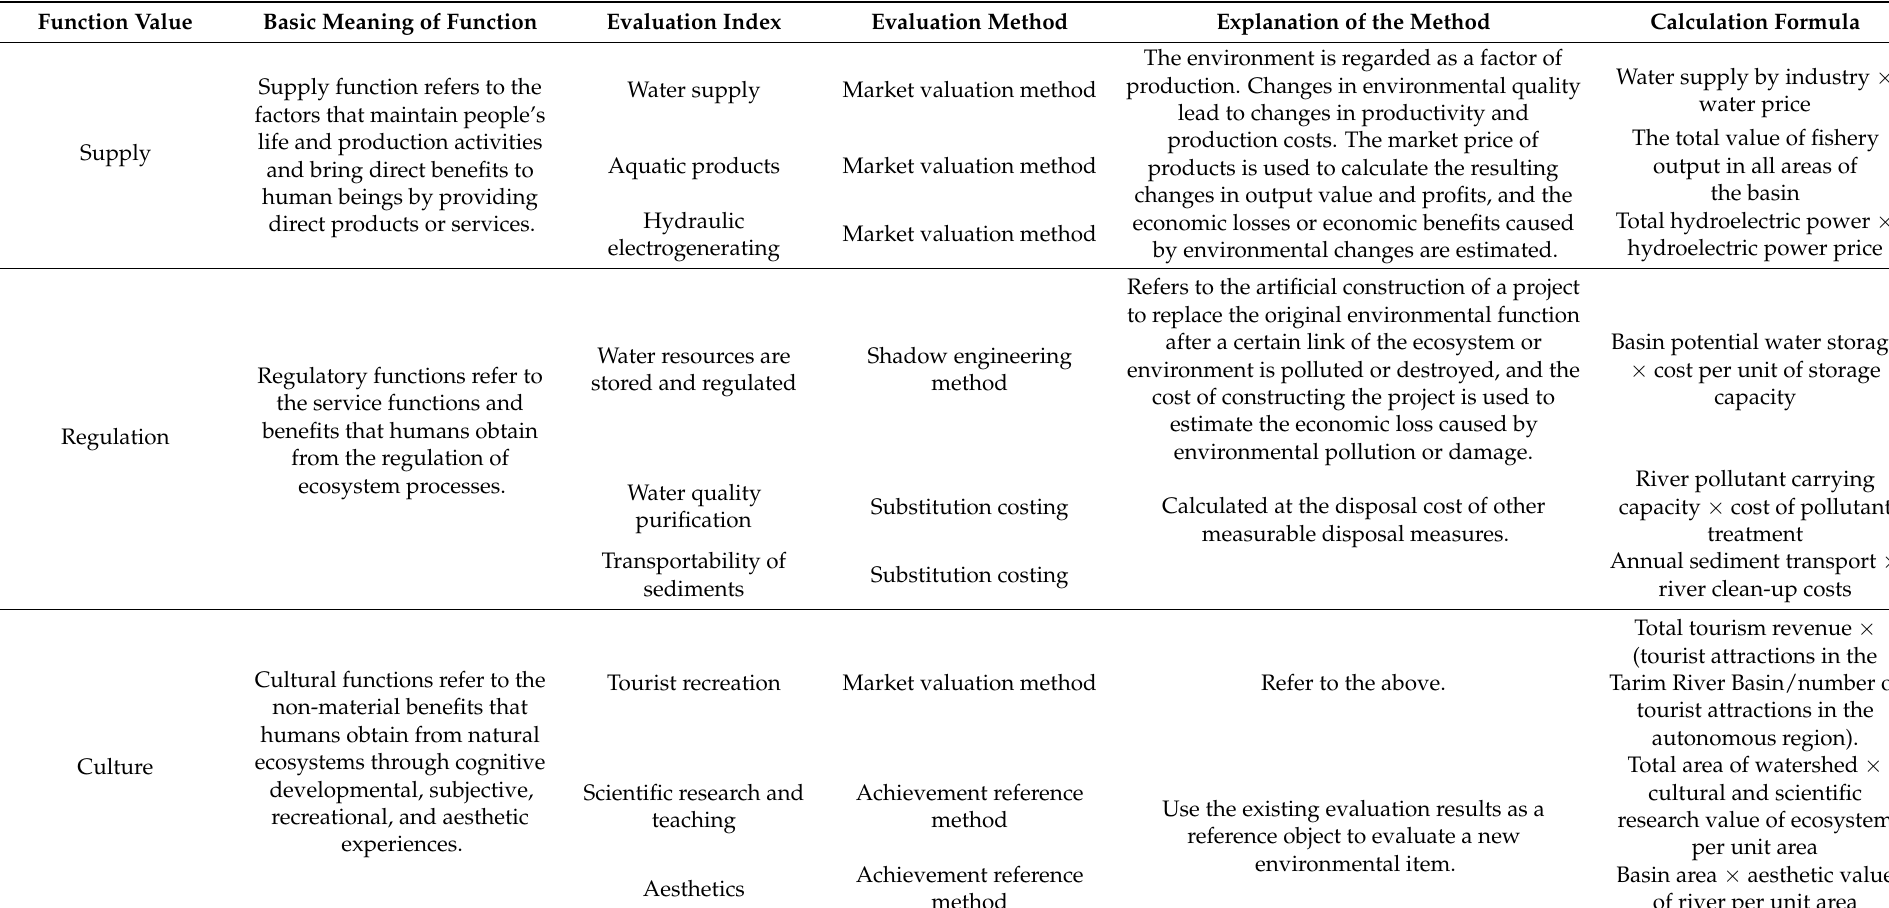
Table 1. Evaluation indexes and methods of the ecosystem service value in the Tarim River